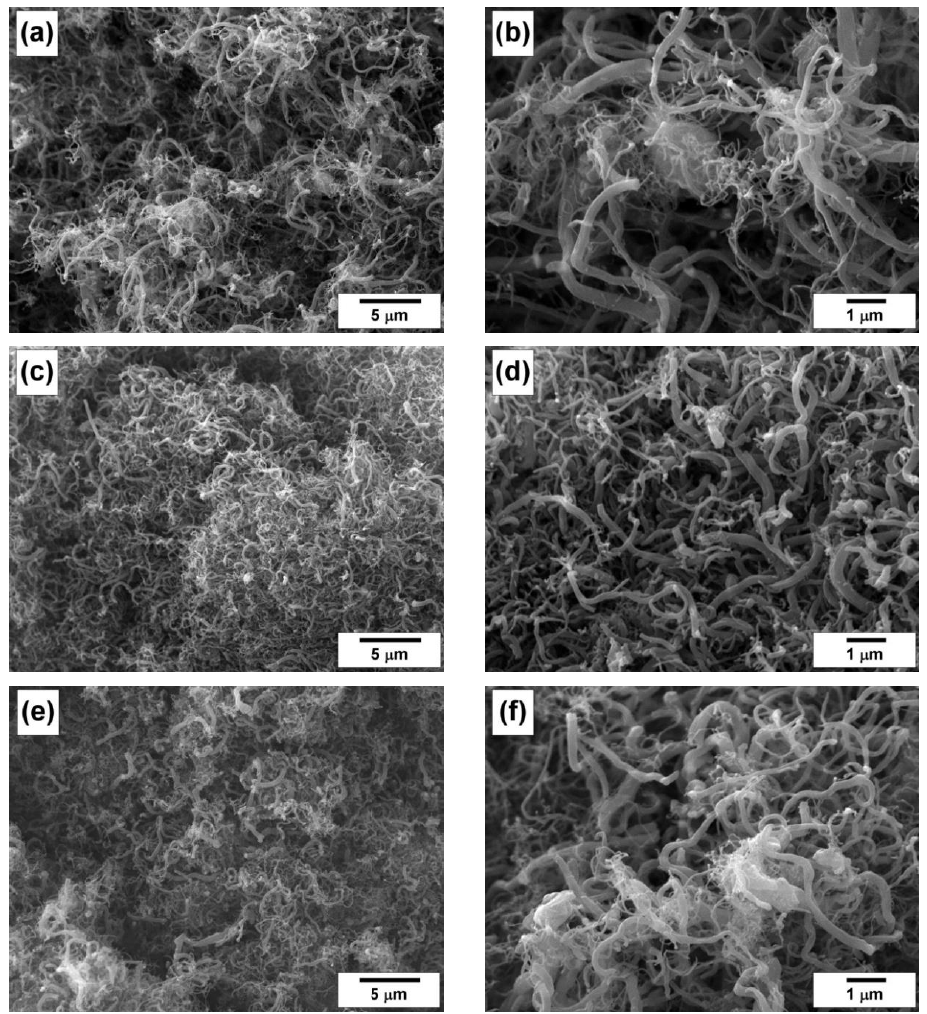
Figure 8. SEM images of the carbon nanofibers obtained via the decomposition of the methane– hydrogen mixture at ( a,b ) 550 °C; ( c,d ) 600 °C; ( e,f ) 625 °C.